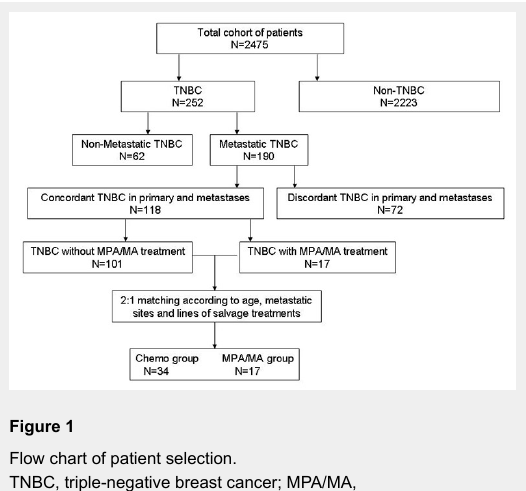
Flow chart of patient selection. TNBC, triple-negative breast cancer; MPA/MA, medroxyprogesterone acetate/megestrol